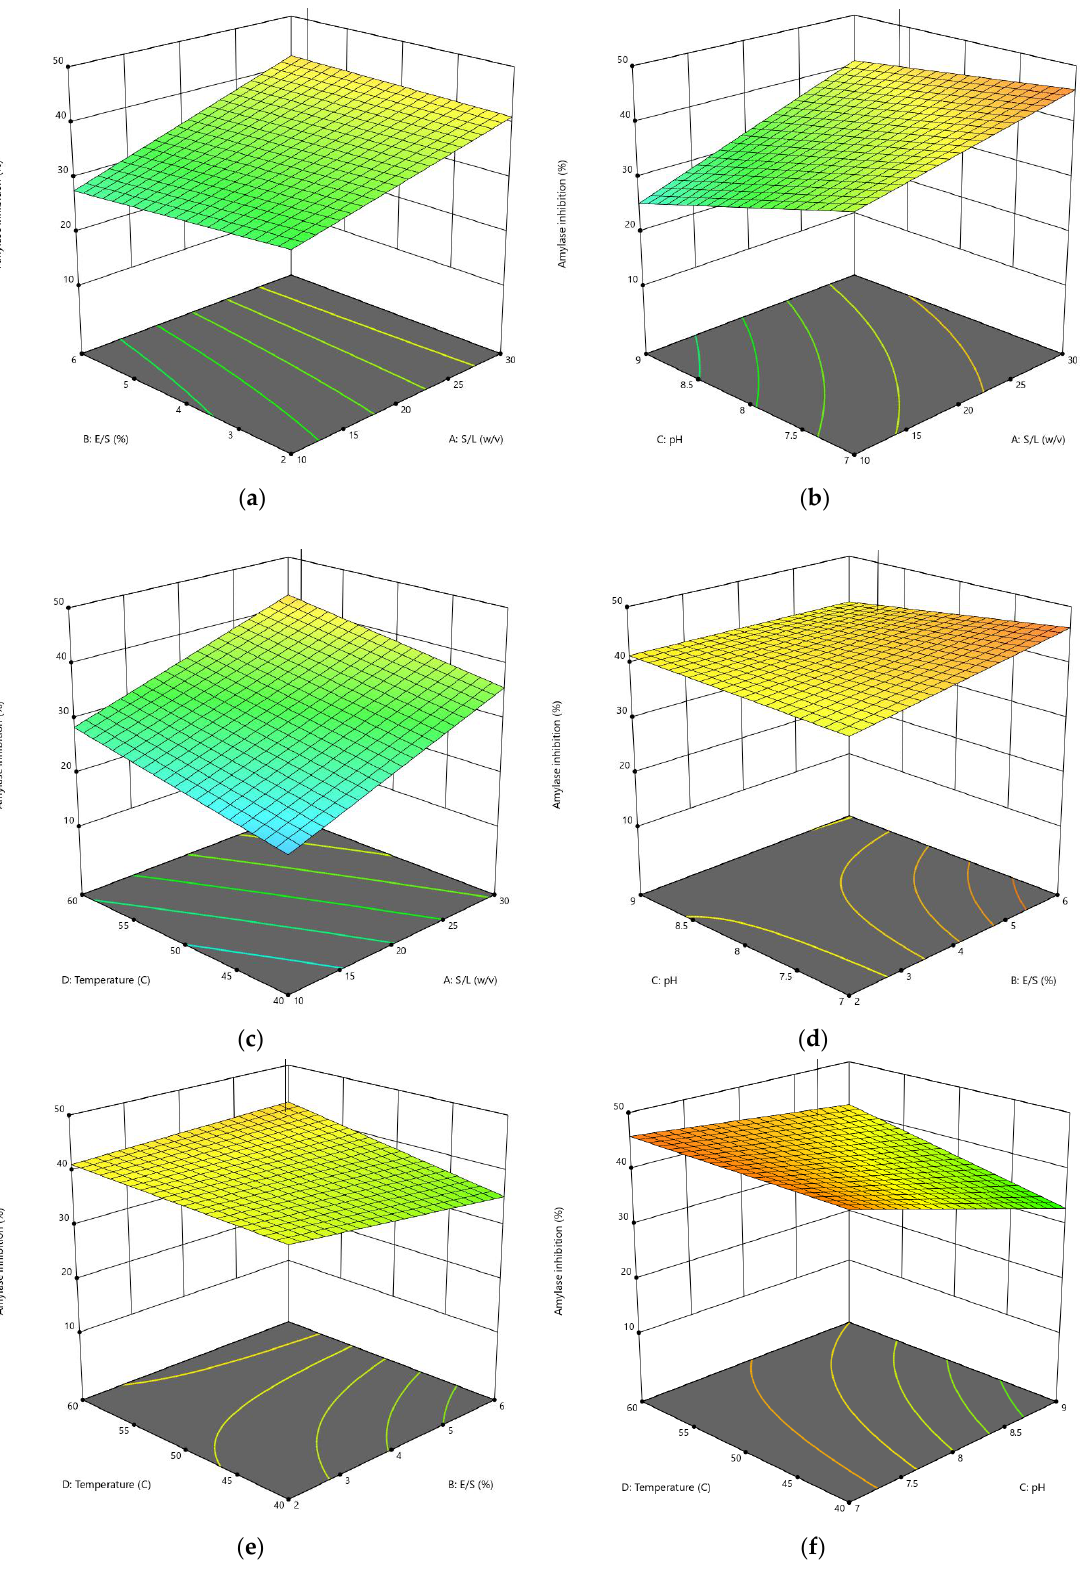
Figure 4. 3D response surface plots showing the influence of variable parameters on the α -amylase inhibition activity response using trypsin: ( a ) E/S ratio vs. S/L ratio, ( b ) pH vs. S/L ratio, ( c ) tem- perature vs. S/L ratio, ( d ) pH vs. E/S ratio, ( e ) temperature vs. S/L ratio, and ( f ) temperature vs. pH.